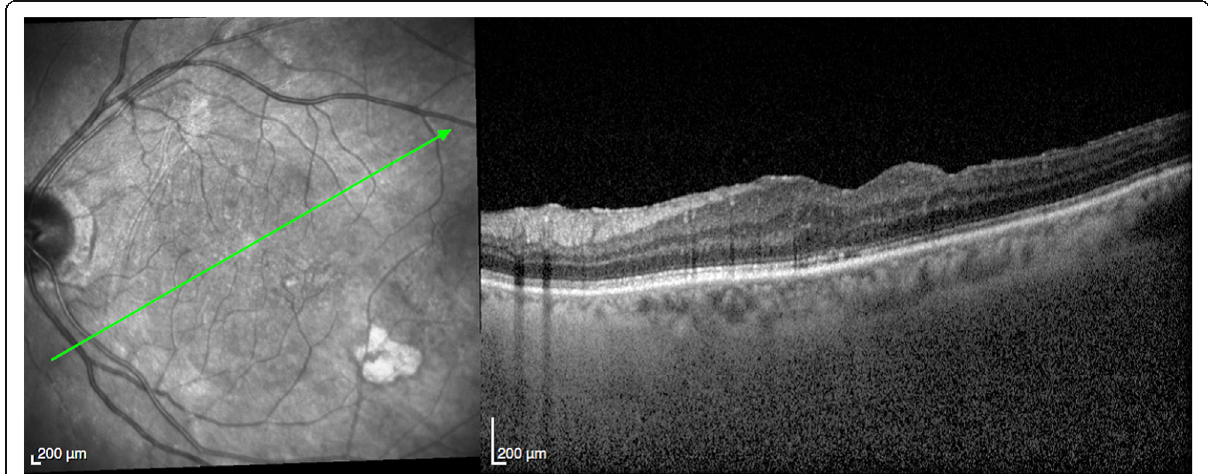
Fig. 7 Patient 2. OCT at the last follow-up visit with decreased intraretinal